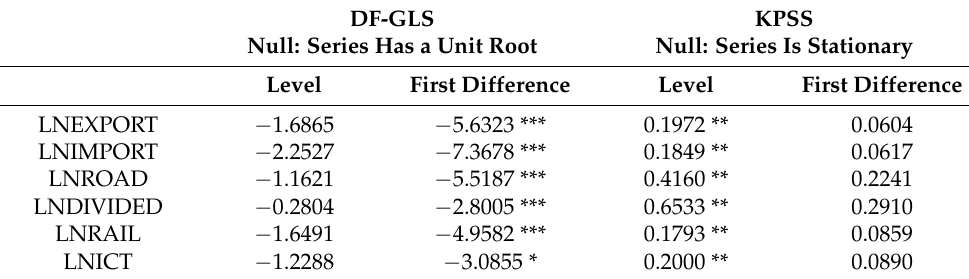
Table 3. Stationarity test